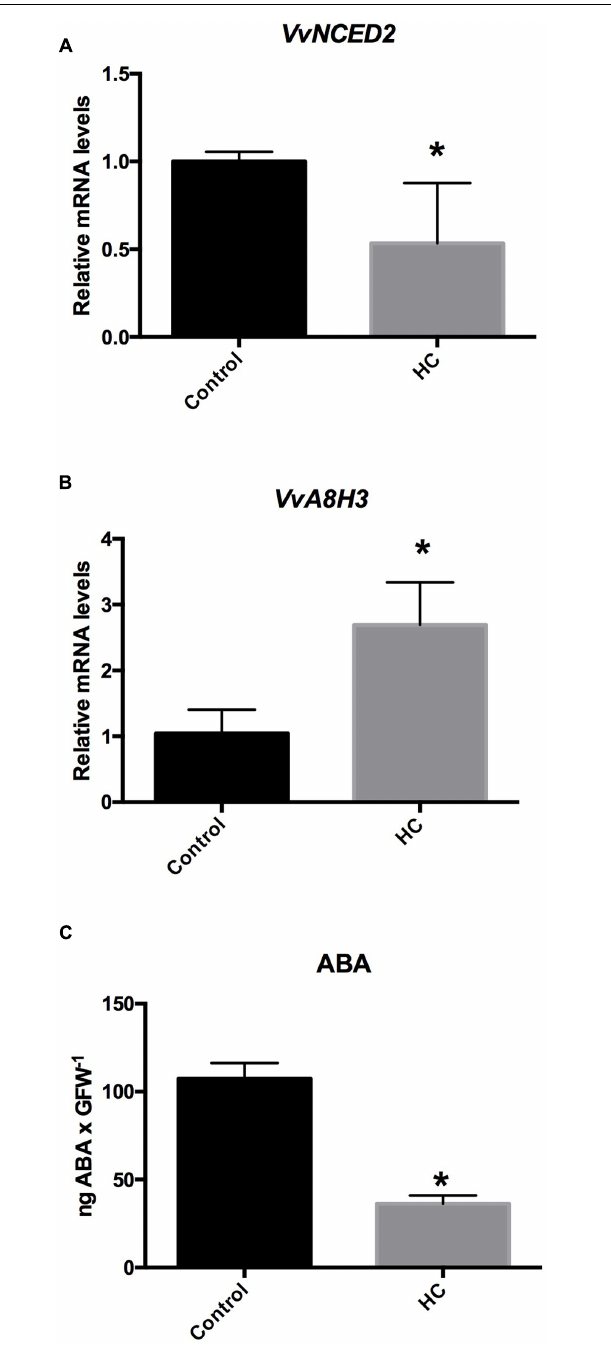
FIGURE 5 | Hydrogen cyanamide (HC) altered the expression of ABA metabolism-related genes (A,B) and reduced the content of ABA in grapevine buds (C) . HC down-regulated the expression of the ABA biosynthesis gene VvNCED2 (A) and up-regulated the expression of the ABA catabolism-related gene VvA8H3 (B) and reduced the content of ABA (C) in Thompson seedless grapevine buds. Gene expression analysis was performed by RT-qPCR, values were normalized against VvUBIQUITIN , and the content of ABA was determined as described in the Section “Materials and Methods”. Values are the average of three biological replicates with ± SD; (asterisk) Student’s t -test ( α = 0.05).